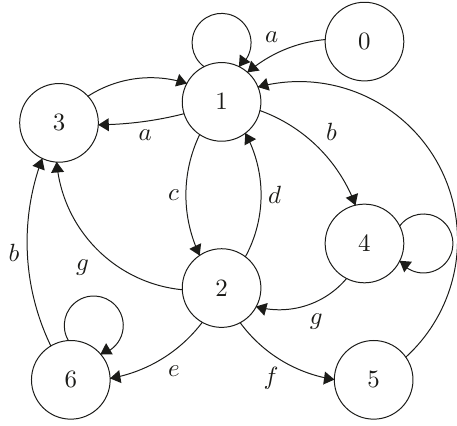
Fig. 2. A schematic diagram of Flexometer with CS5460 IC and Raspberry Pi microcontroller.